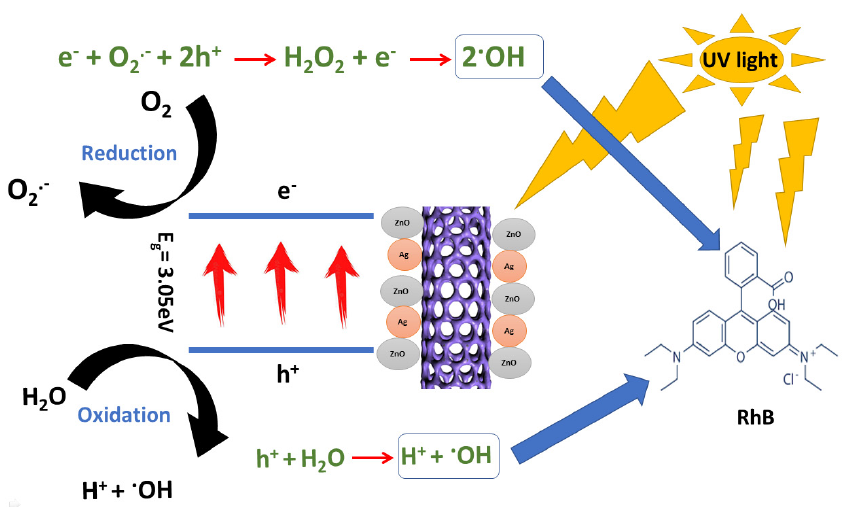
Figure 8. Schematic illustration of the photocatalytic mechanism of the photocatalyst for degradation of RhB.